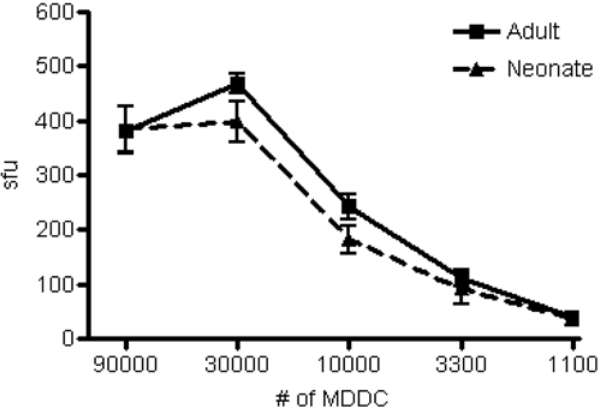
Figure 2. DC from adults and neonates are comparable in their ability to present the M.tuberculosisantigen pronase-digested cell wall to HLA-E-restricted clone D160-1-23. DC from adult ( n= 5) and neonatal ( n= 6) blood were incubated overnight with or without the pronase- treated cell wall fraction from M.tuberculosis . The DC were diluted over a range of concentrations (90,000 to 1100 cells/well), and incubated with the cognate CD8 + HLA-E-restricted clone D160-1-23 (10,000 cells/ well) overnight. IFN- c was detected by ELISPOT. There was no statistically significant difference between adult and neonatal DC in presentation of pronase-digested cell wall to HLA-E-restricted CD8 + T cells (p=0.7943).